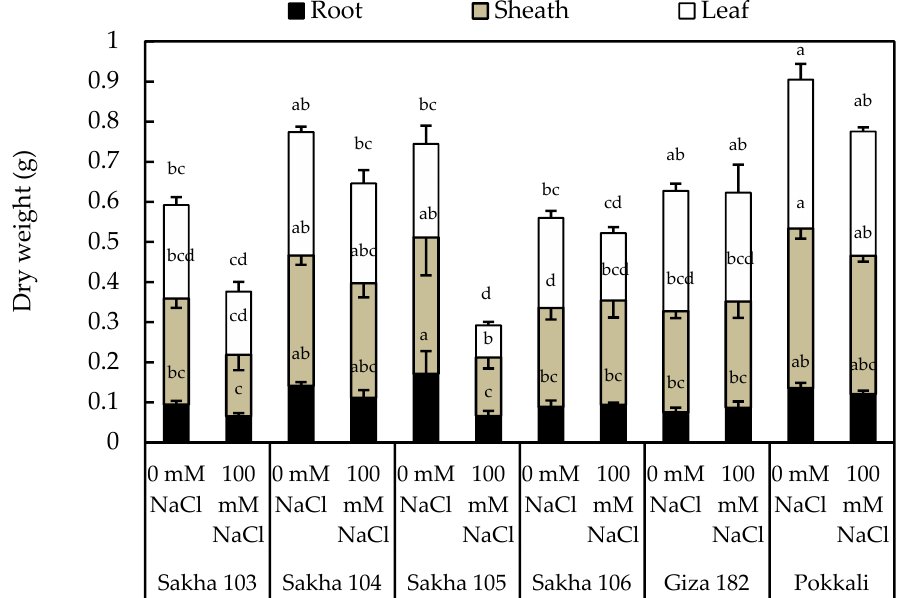
Figure 1. Effect of salinity stress (100 mM NaCl) on dry weight of Sakha 103–106, Giza 182, and Pokkali after 14 days of treatment. Data represent the means ± SE (standard errors, n = 4). The bars with the same letter on the top are not significantly different ( p ≤ 0.05). The terms sheath and leaf indicate the leaf sheath and leaf blade, respectively.